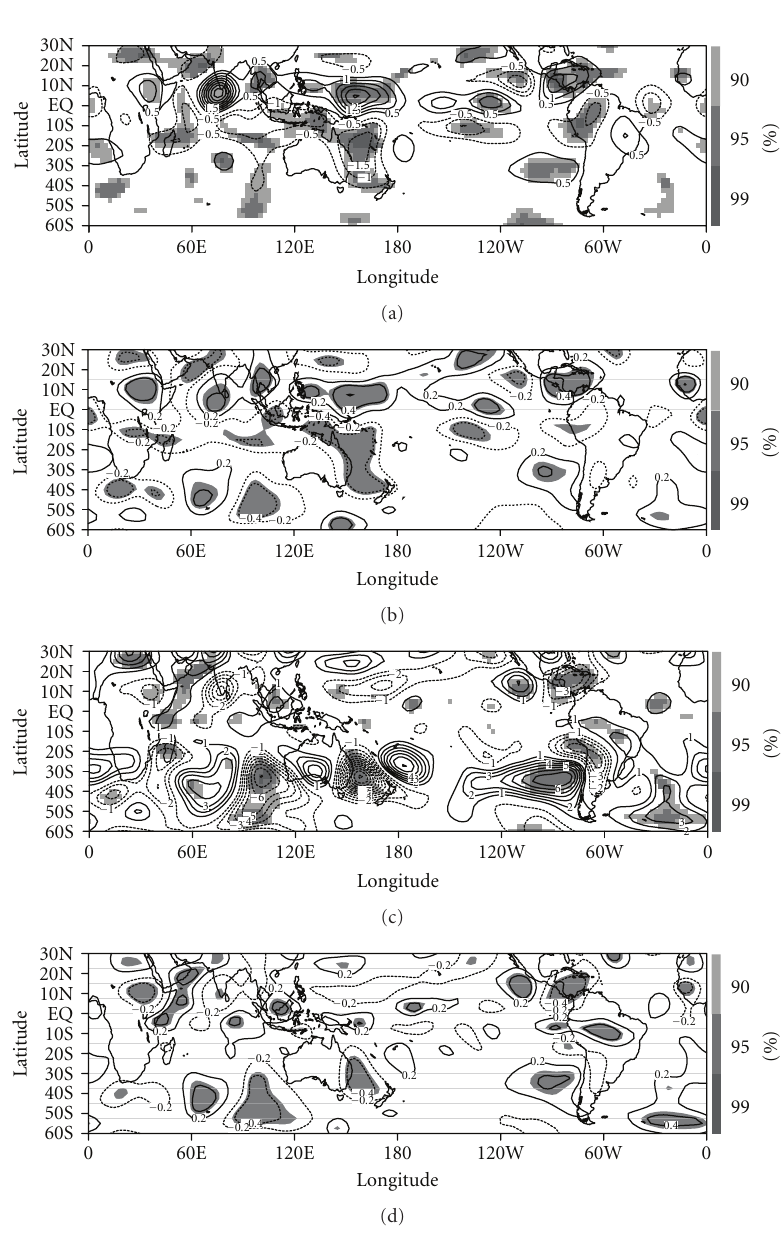
Figure 6: (a) Di ff erence between strong and weak HC cases for divergence at 200 hPa, (b) correlation between austral winter HCI and divergence at 200 hPa, (c) di ff erence between strong and weak HC cases for Rossby wave source at 200hPa, (d) correlation between austral winter HCI and the Rossby wave source at 200 hPa. The shaded areas in grey scale (see vertical bar) are statistically significant values at the 90%, 95%, and 99% levels according to a two-tailed Student’s t -test, and the contour interval is 0.5 × 10 − 6 s − 1 for (a) and 1 × 10 − 11 s − 2 for (c). In (b) and (d) regions exceeding 95% significance level ( > r = 0 . 349) are shaded, and the contour interval is